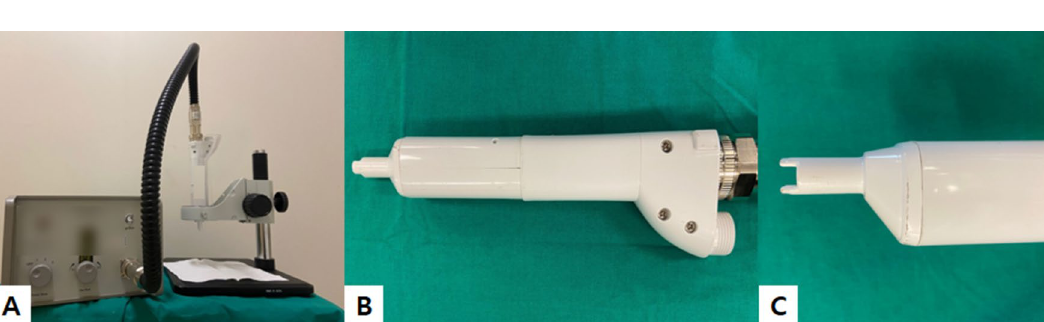
Figure 1. Experimental design for the in vivo study using the mouse model of atopic dermatitis.